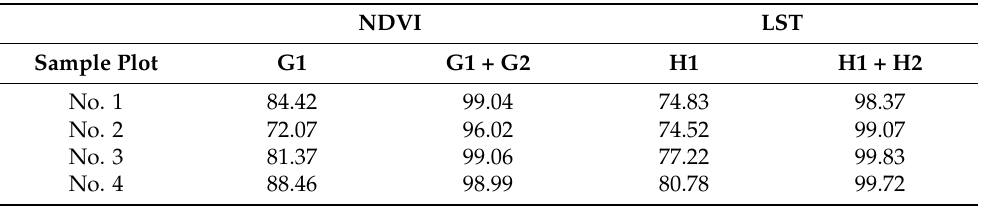
Table 3. Contributions of the first two principal components, G1 and G2 for NDVI and H1 and H2 for LST, to the total NDVI and LST variance for different sample plots. NDVI Sample